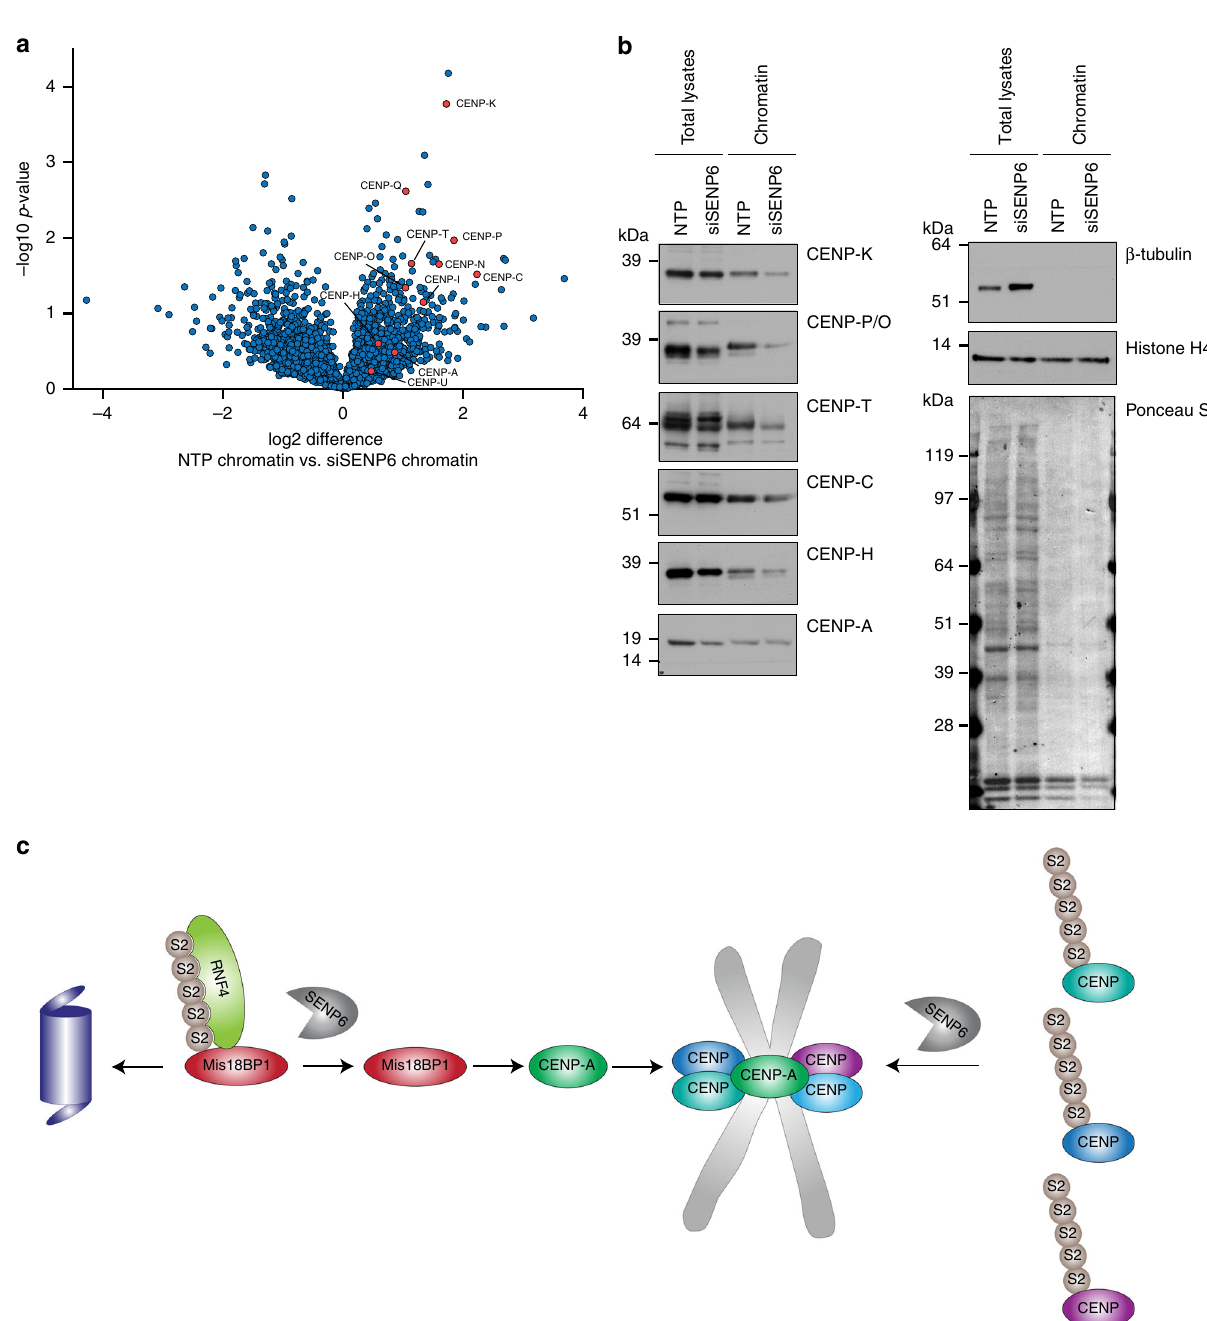
Fig. 9 SENP6 knockdown leads to the depletion of multiple CCAN proteins from chromatin. a U2OS cells were transfected either with a pool of four siRNAs against SENP6 (siSENP6) or a pool of four nontargeting siRNAs (NTP). Chromatin fractions were isolated and proteins were analyzed by mass spectrometry. Volcano plot showing all identi fi ed proteins within the NTP treated sample compared with the siSENP6 treated sample. All identi fi ed inner kinetochore proteins are represented by red circles. n = 4 independent experiments. b Samples from panel a were analyzed by immunoblotting using antibodies against several inner kinetochore proteins, as well as β -tubulin and histone H4 as control for ef fi cient fractionation. Source data are provided as a Source Data fi le. c Model of SENP6 regulation of CCAN proteins. SENP6 deSUMOylated CCAN proteins as well as Mis18BP1. SENP6 depletion leads to RNF4-mediated degradation of Mis18BP1 and consequently the failure of CENP-A to accumulate at the centromere. Reduced CENP-A levels as well as accumulated SUMO chains on other CCAN family members hinder ef fi cient CCAN protein complex formation at the